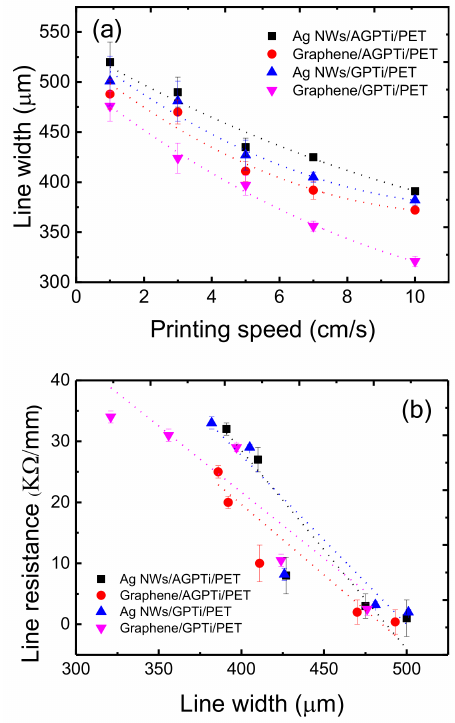
Figure 8. ( a ) Relationship between the printing speed and line width. ( b ) Change in line resistance as a function of the line width.